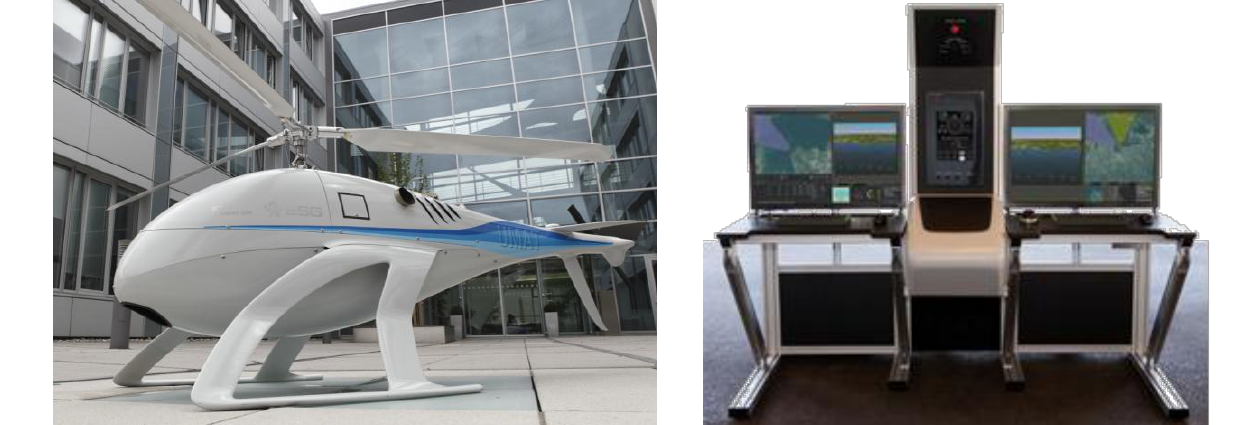
Fig. 1 Unmanned Mission Avionics Test Helicopter based on Swiss UAV NEO S-350 Twin